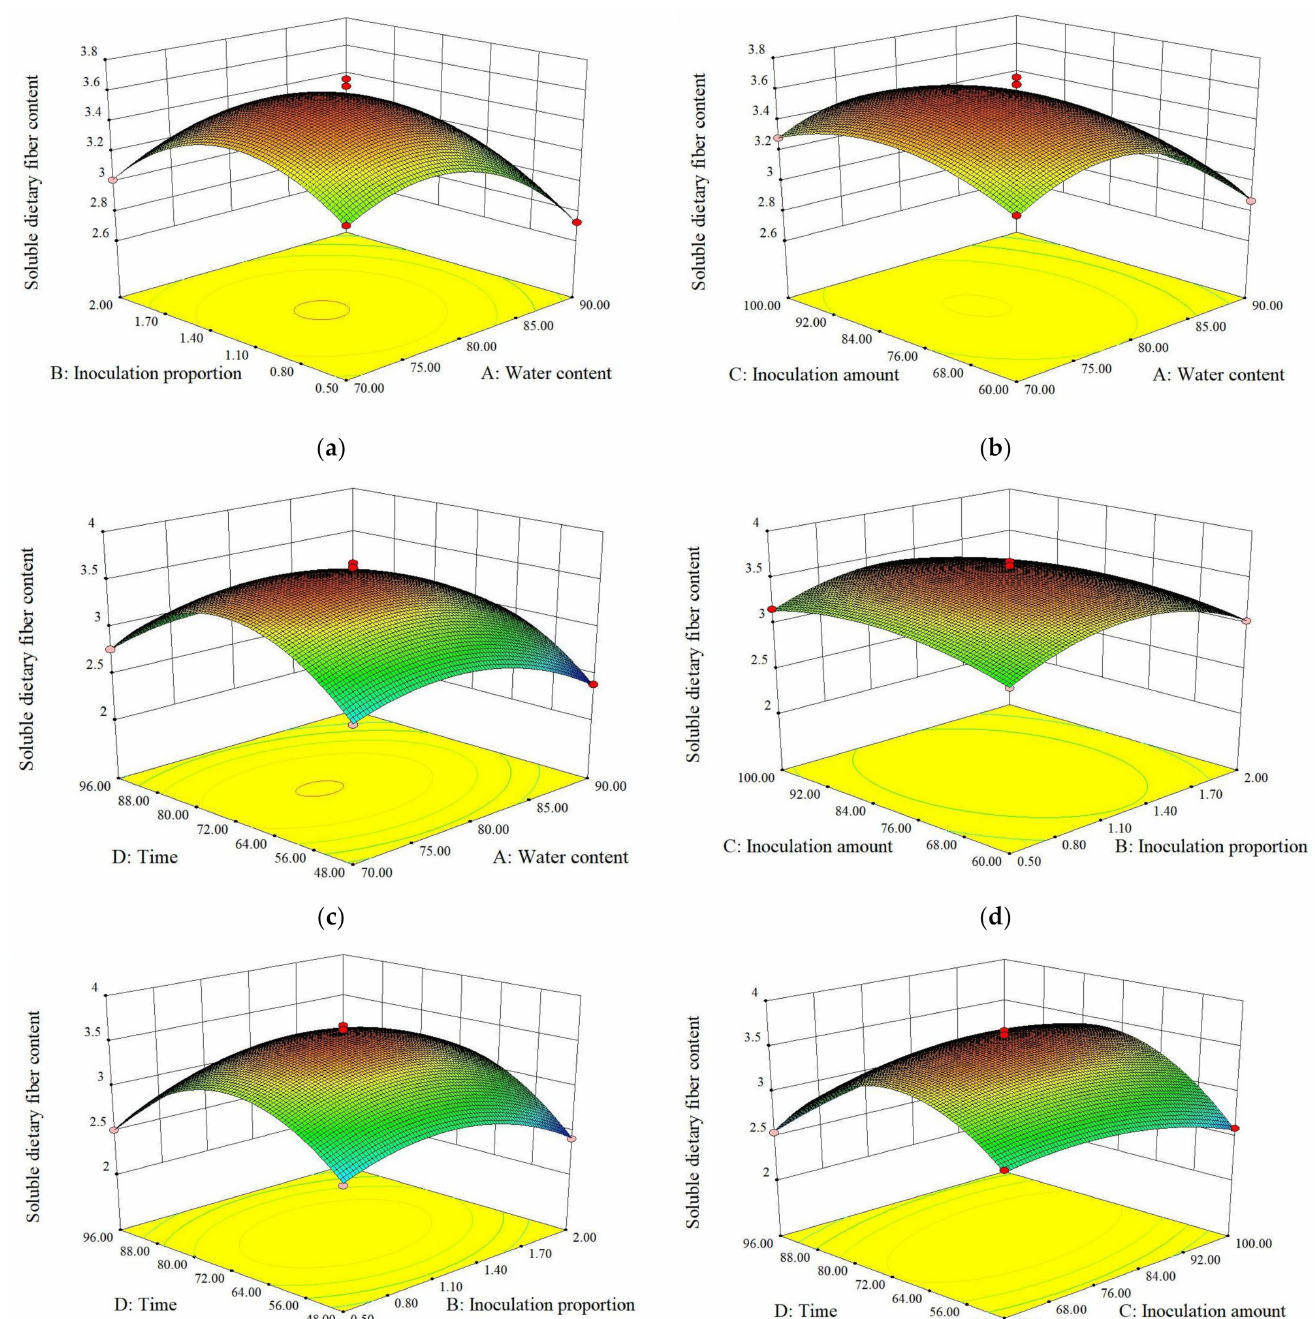
Figure 1. Response surface diagram. Effect of water content and inoculation proportion on SDF yield ( a ); influence of water content and inoculation amount on SDF yield ( b ); effect of water content and fermentation time on SDF yield ( c ); effect of inoculation proportion and inoculation amount on SDF yield ( d ); effect of inoculation proportion and fermentation time on SDF yield ( e ); effect of inoculation amount and fermentation time on SDF yield ( f